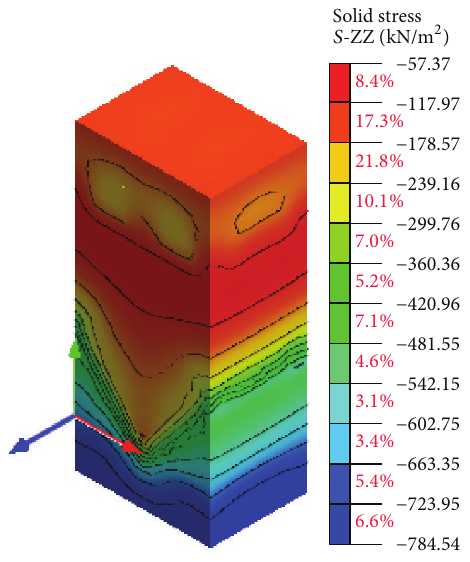
Figure 13: FEM results of earth pressure under the loading of 150